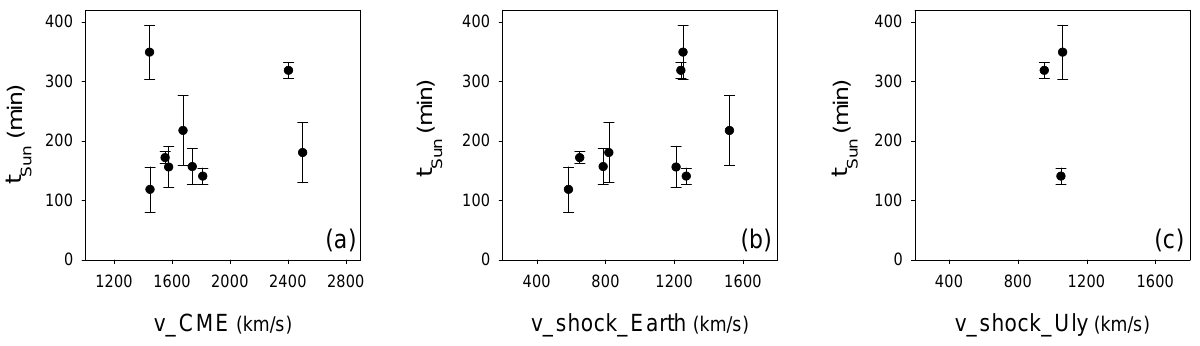
Fig. 7. Release time from Ulysses measurements versus (a) the speed of the CME from SOHO/LASCO coronograph observations; (b) the average transit speed of the CME driven shock in the ecliptic; (c) the average transit speed of the CME driven shock at high latitudes.